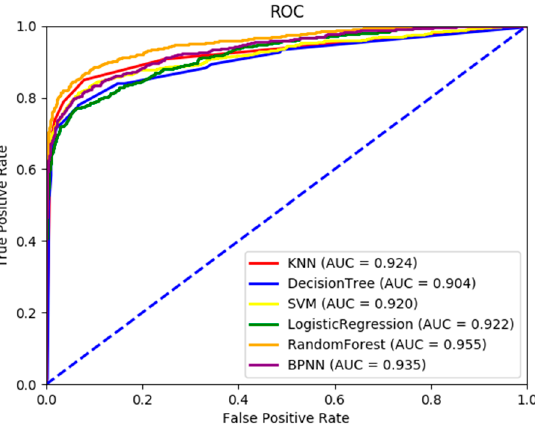
According to the calculation results of the six machine learning algorithms (Table 5), it can be seen that the Random Forest model had the best performance; its accuracy rate was 0.923, the model generalization ability was the best (AUC = 0.955), and the model had no overfitting phenomenon; the learning and ROC curves are shown in Figure 9. The sec- ond is the Artificial Neural Network model, with an accuracy rate of 0.937 and an AUC of 0.935, followed by the Nearest Neighbor model, Logistic Regression model, and Support Vector Machine model, with AUCs of 0.924, 0.922, and 0.920, respectively; the worst was Figure 8. Comparison of ROC and AUC of six machine learning early-warning models.